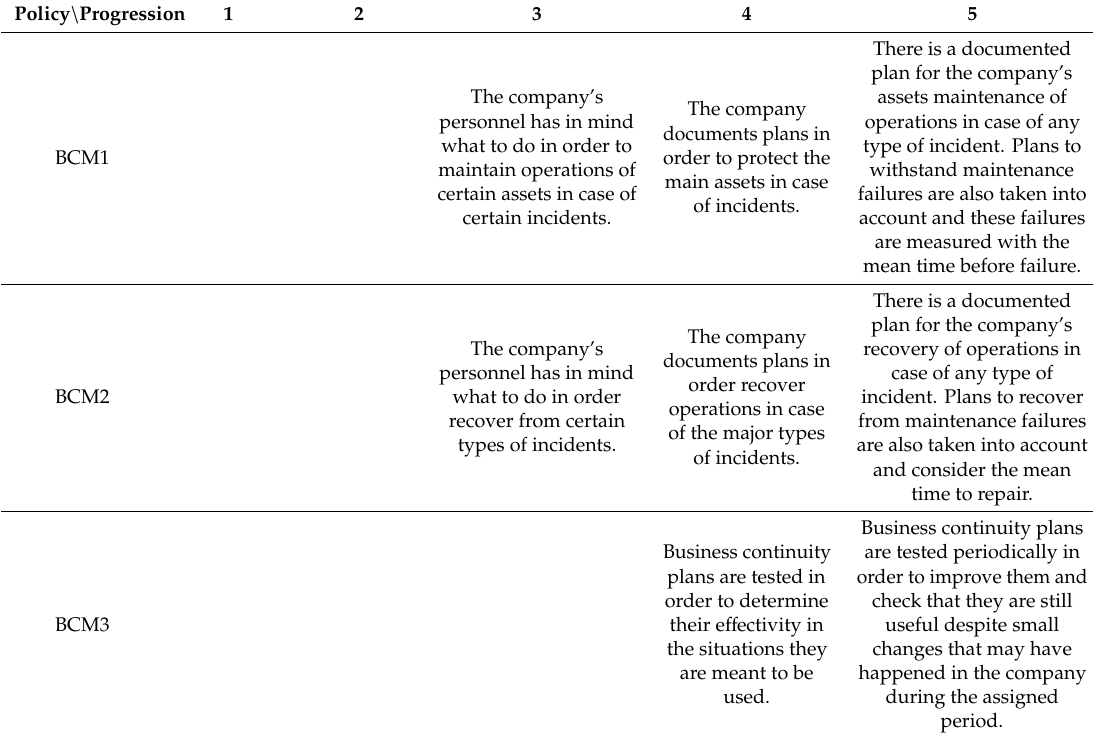
Table 28. Business continuity management policies’ progression model.